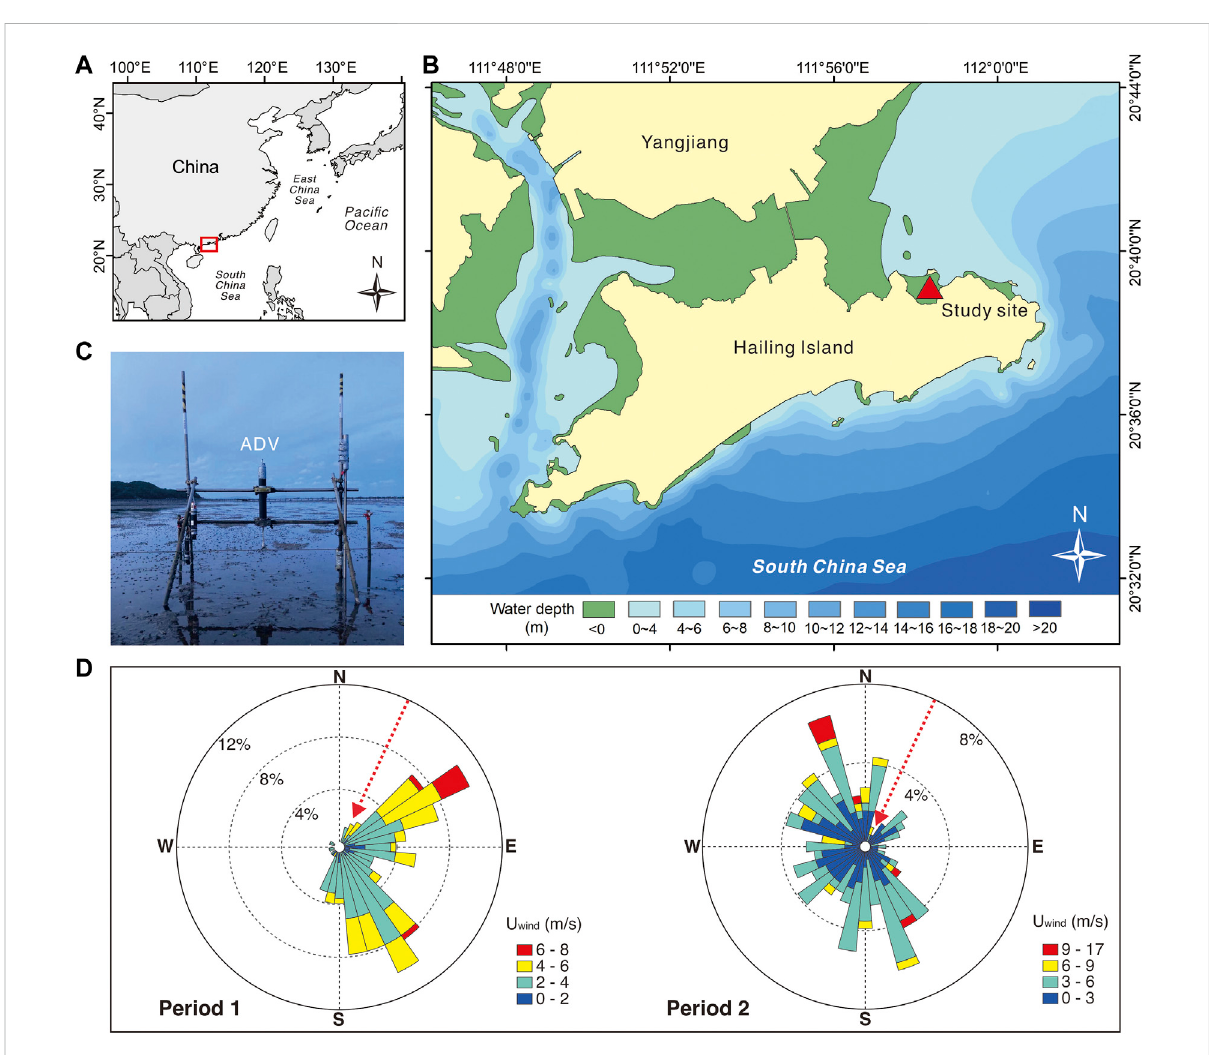
FIGURE 1 (A) Location ofthe study site near thewest Paci fi cOcean. (B) Map of Hailing Island with the observation site and wind gauge. (C) Photograph of the deployed instrument. (D) Wind roses of Period 1 (March 26 – 26 April 2021) and Period 2 (July 8 – 8 August 2021). The red arrow indicates the orientation of the